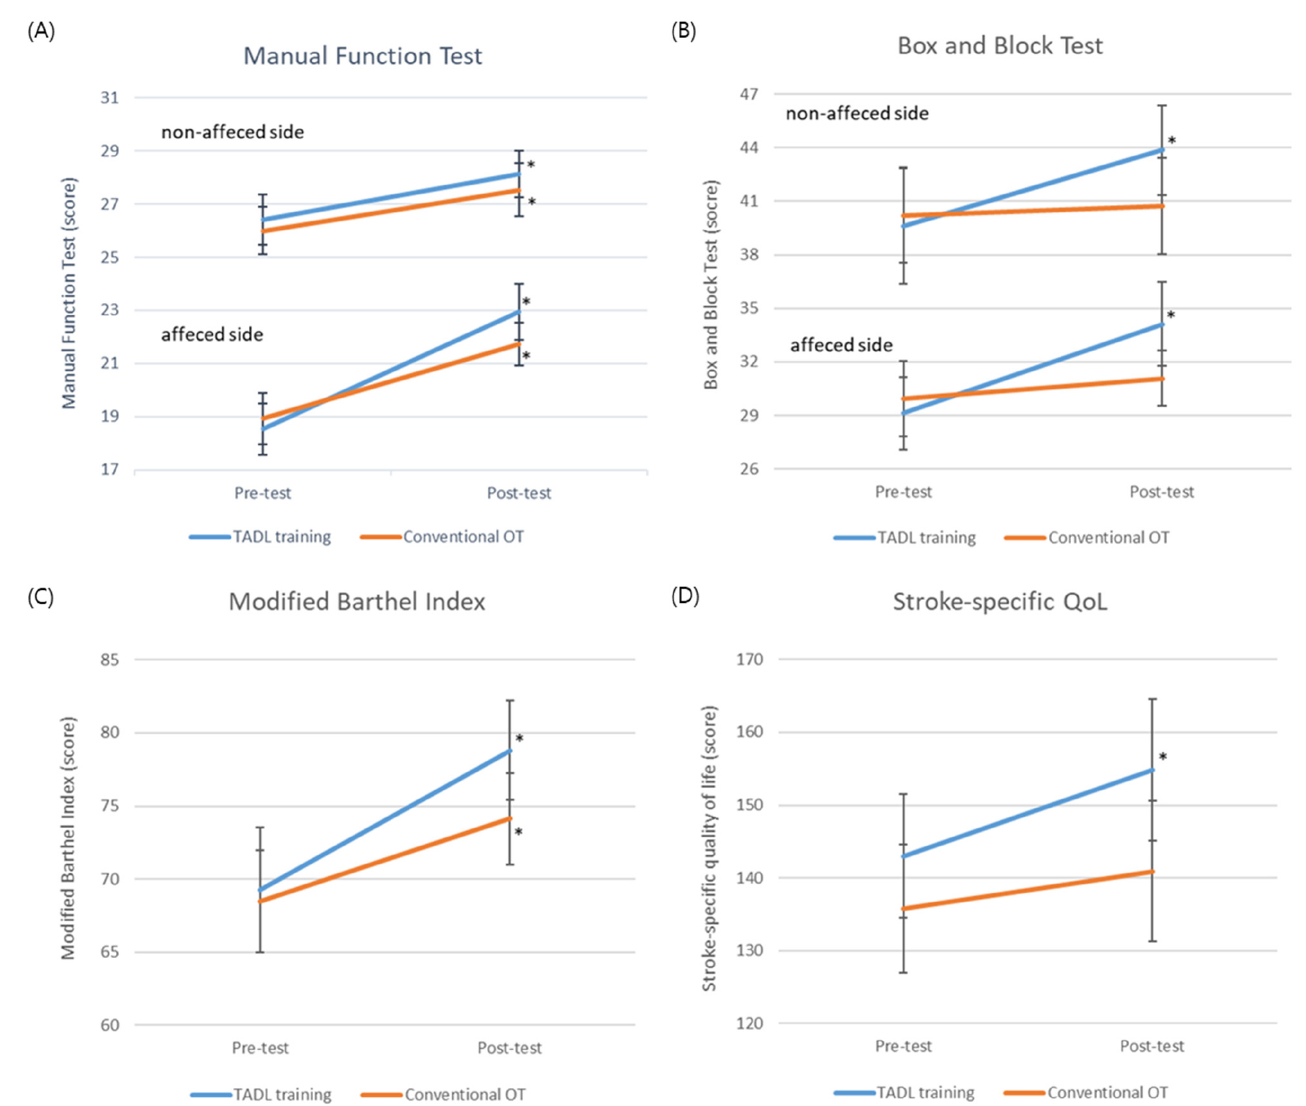
Figure 1. Primary and secondary outcomes at pre and post intervention ( A ) Manual function test, ( B ) Box and block test ( C ) Modified Barthel index, ( D ) Stroke-specific quality of life. Abbreviations: TADL, task-oriented activities of daily living; OT, occupational therapy; QoL, quality of life * significantly changes from pre-test to post-test.